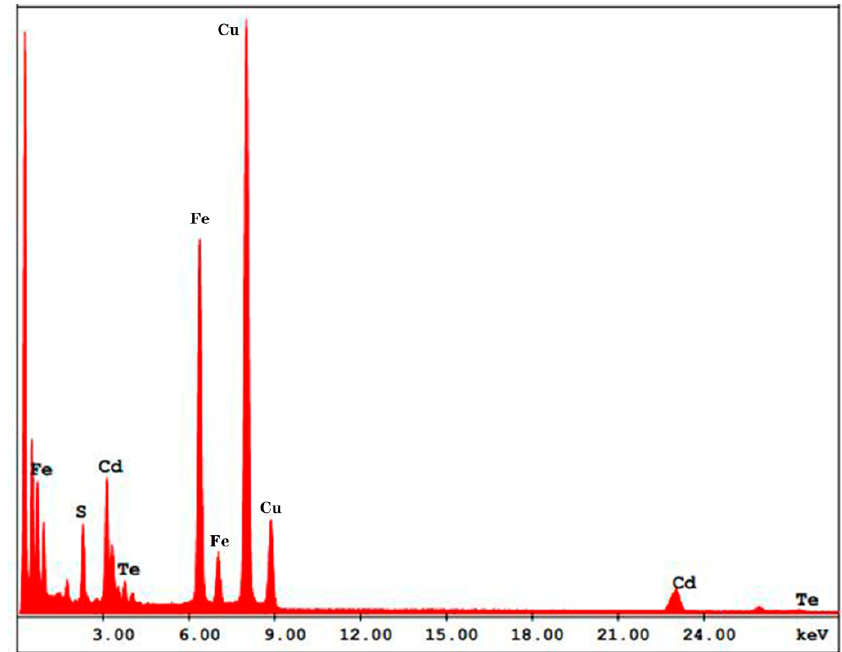
Figure 3. The energy dispersive spectrum of DMFN.